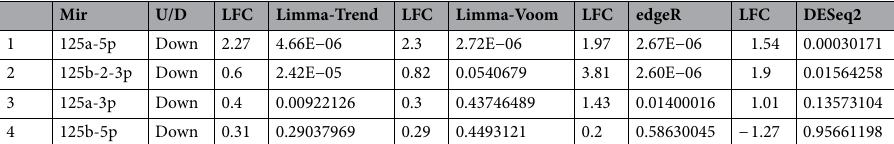
Table 3. hsa-miR-125 family in deep sequencing using four different methods for differential expression analysis. U/D up /down, LFC log fold